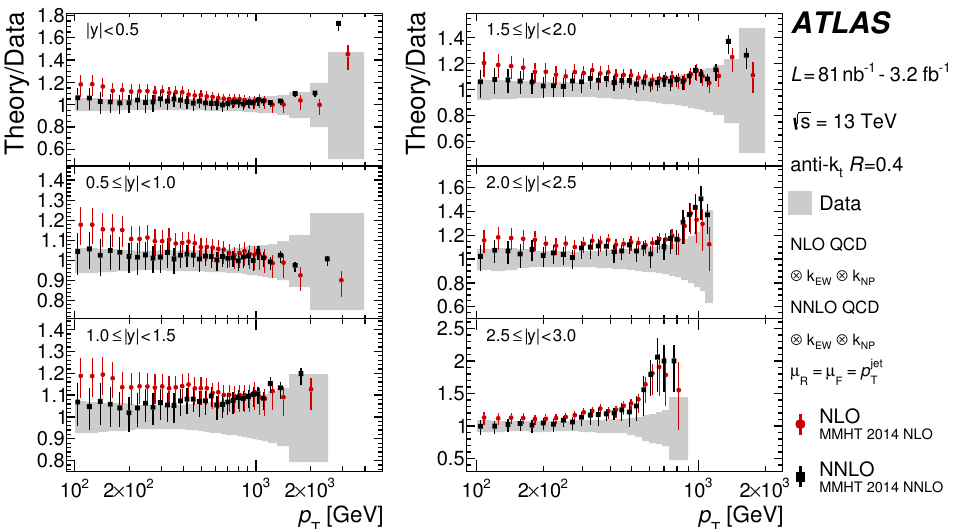
Figure 11 . Ratios of the NLO and NNLO pQCD predictions to the measured inclusive jet cross- sections, shown as a function of the jet p T in six j y j bins for anti- k t jets with R = 0 : 4. The NLO predictions are calculated using NLOJET++ with the MMHT 2014 NLO PDF set. The NNLO predictions are provided by the authors of refs. [17, 18] using NNLOJET with p jet as the QCD scale T and the MMHT 2014 NNLO PDF set. Non-perturbative and electroweak corrections are applied to the predictions. The NLO and NNLO uncertainties are shown by the coloured lines, including all the uncertainties discussed in section 9. The grey bands show the total data uncertainty including both the systematic (JES, JER, unfolding, jet cleaning, luminosity) and statistical uncertainties.